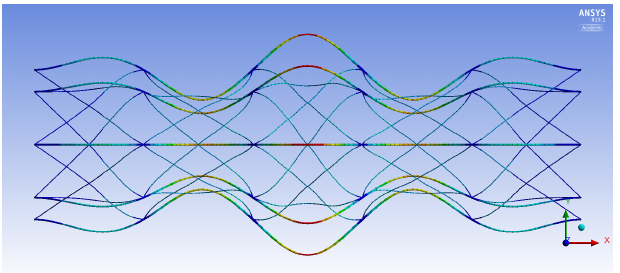
Figure 4. Local buckling of an outer longitudinal IsoTruss structure (side view)